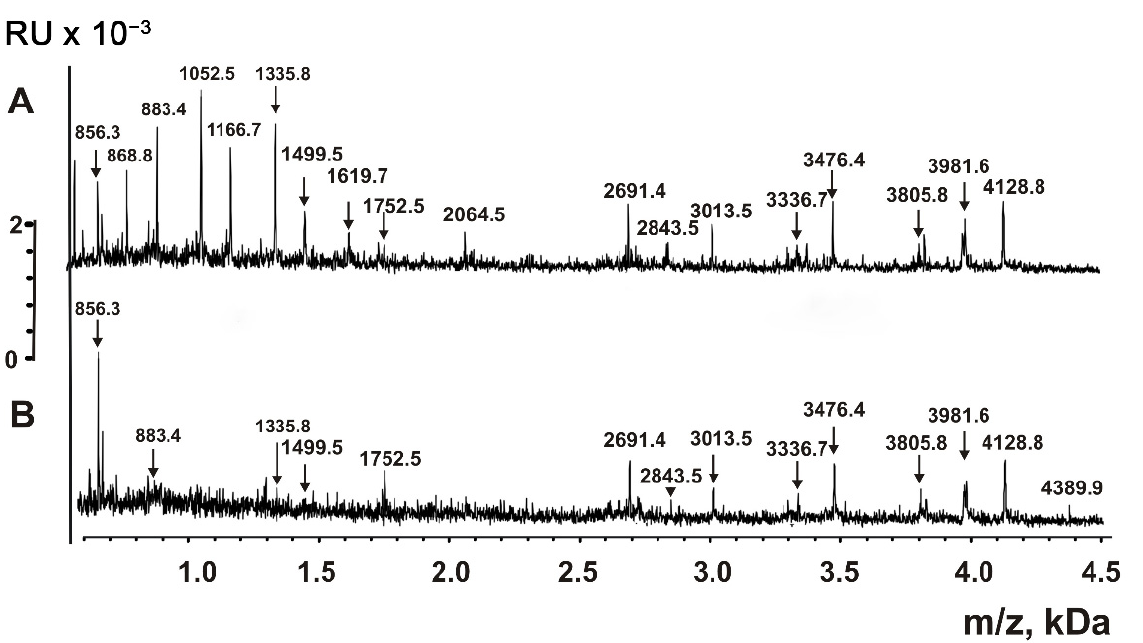
Figure 8. MALDI mass spectra of P2 + P3 subfraction of horse milk exosome extracts obtained after affinity chromatography on anti-CD9- ( A ) and anti-CD63-Sepharose ( B ). The extracts were obtained by destruction of P2 subfraction with TFA and acetonitrile, and the compounds passed through the Amicon filter with a 3 kDa cut-off were analyzed. The error in determining the m / z values did not exceed 0.5–1.0 Da.